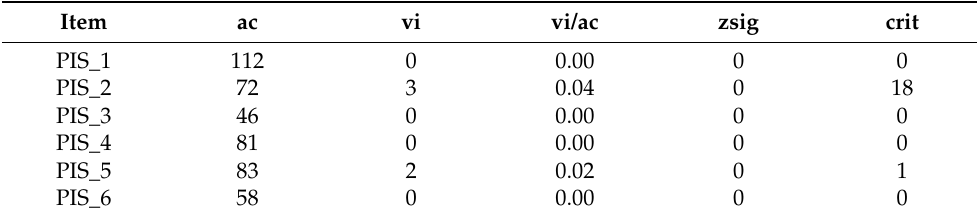
Table 3. Item test for deviations from the